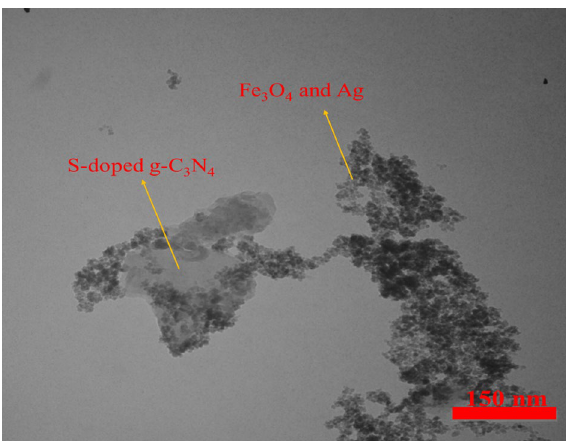
Figure 9. TEM image of the Fe 3 O 4 -g-C 3 N 4 -Alg-Ag